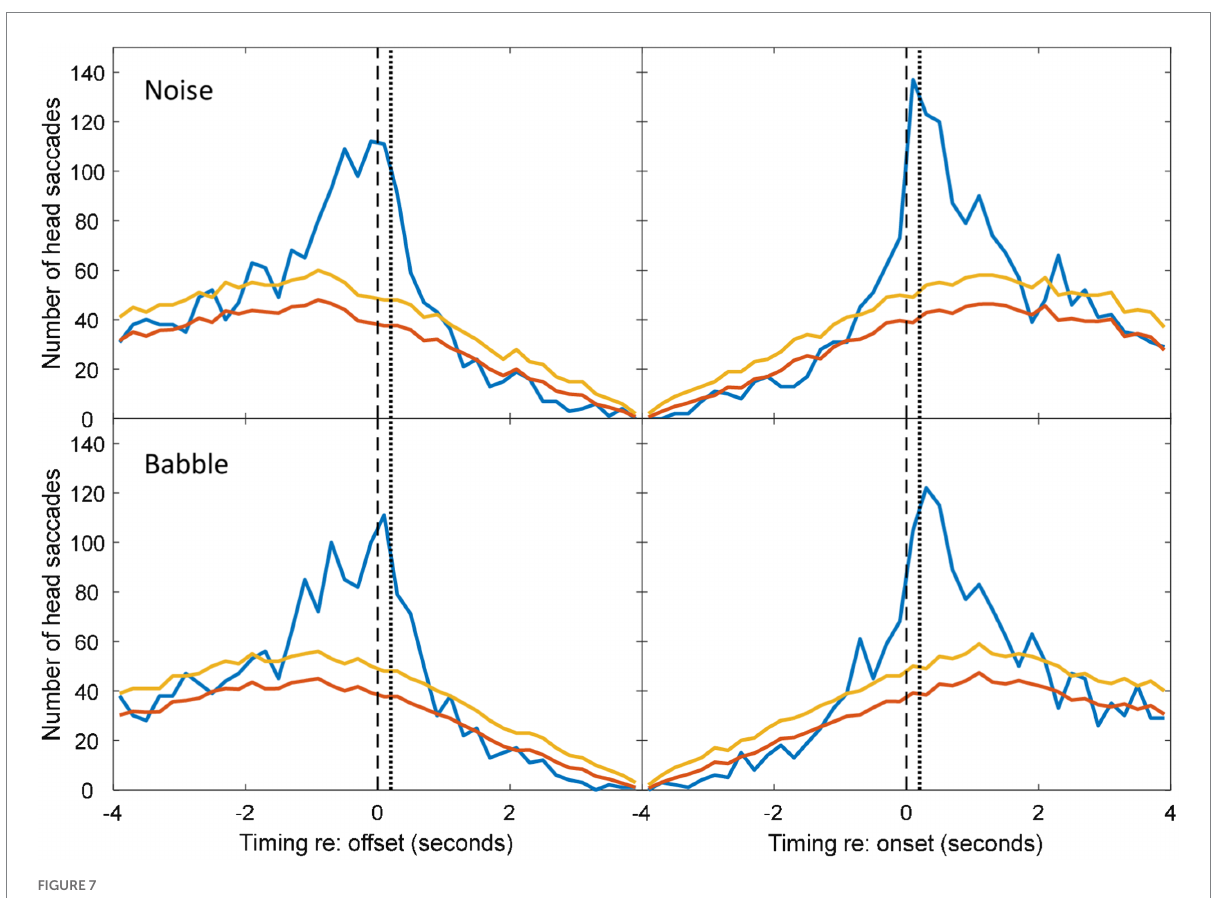
FIGURE 7 As Figure 4, but for head turns during overlapping